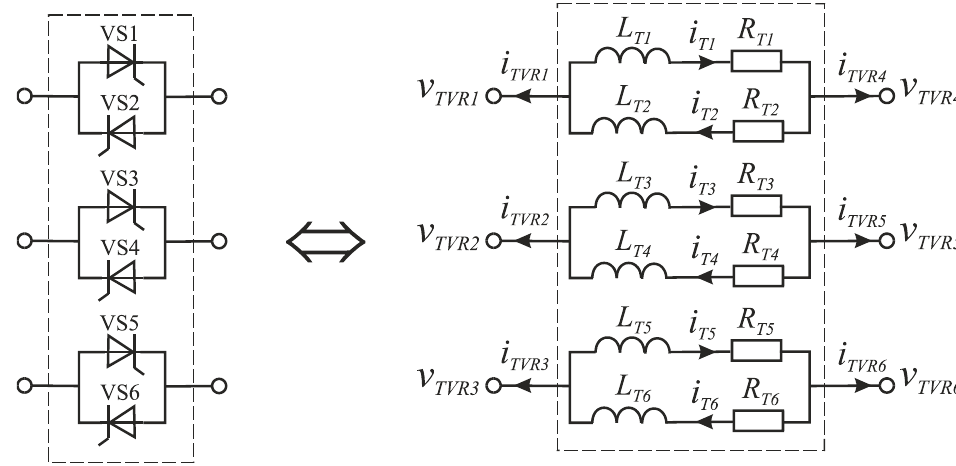
Figure 2. Calculation scheme of power circuit of TVR.